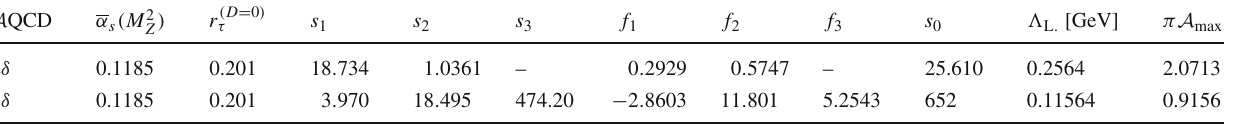
“input” parameter choice is α s ( M 2 0 . 201. 2 δ coupling is in the Lambert scheme with c 2 = − 4 . 9; 3 δ /(cid:12) 2 and f j ≡ F j /(cid:12) 2 . The j L . L .